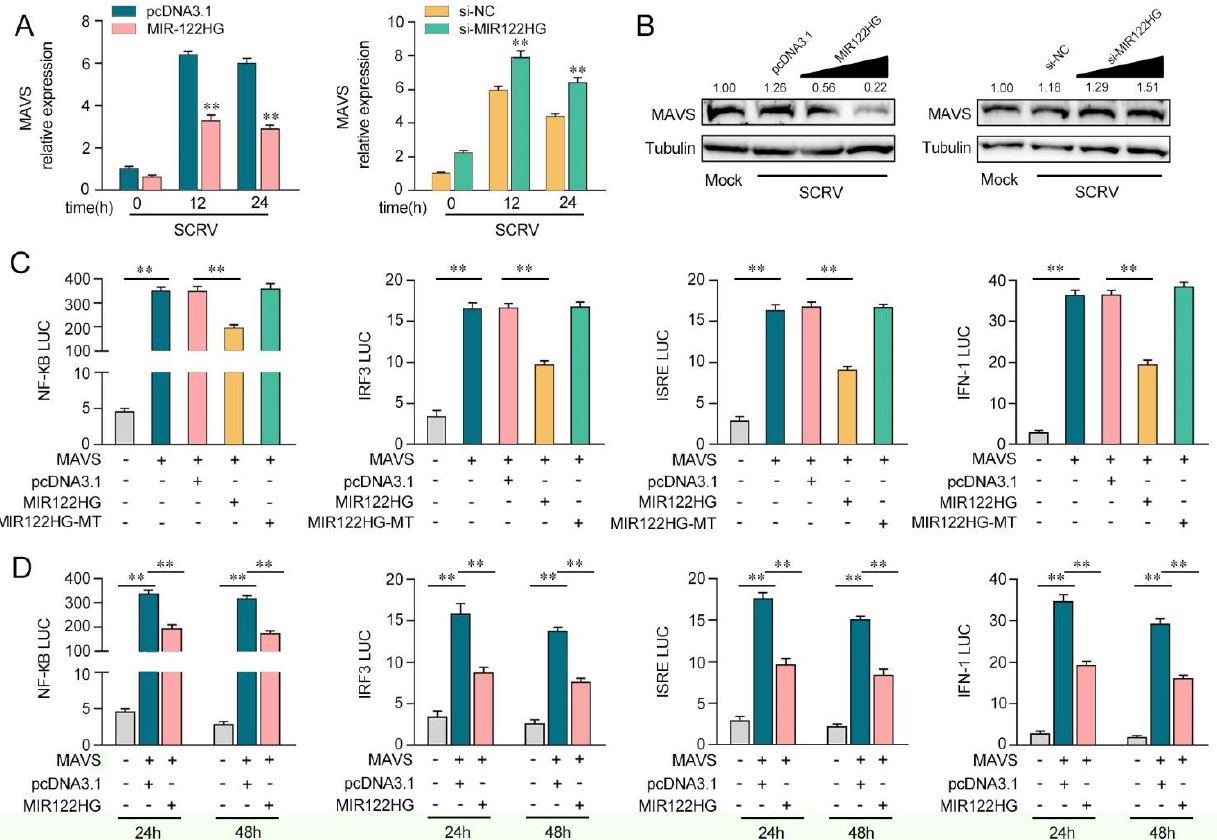
Figure 3. MIR122HG can negatively regulate MAVS-mediated NF- κB and IRF3 signaling. ( A ) The qPCR assays were conducted to measure the expression levels of MAVS in MKCs by transfection with MIR122HG or pcDNA3.1 and si-MIR122HG or si-NC upon SCRV treatment. ( B ) MKCs were cotransfected with MIR122HG (0, 100, 200, and 400 ng) or pcDNA3.1 (400, 300, 200, and 0 ng) and si-MIR122HG (0, 25, 50, and 100 nM) or si-NC (100, 75, 50, and 0 nM) at different concentrations for 24 h, and then the cells were treated with SCRV for another 24 h and the protein levels of MAVS were measured by Western blotting. ( C ) EPC cells were cotransfected with MIR122HG, MIR122HG- MT or pcDNA3.1, along with MAVS expression plasmid, pRL-TK vector, NF- κB, IRF3, ISRE or IFN -